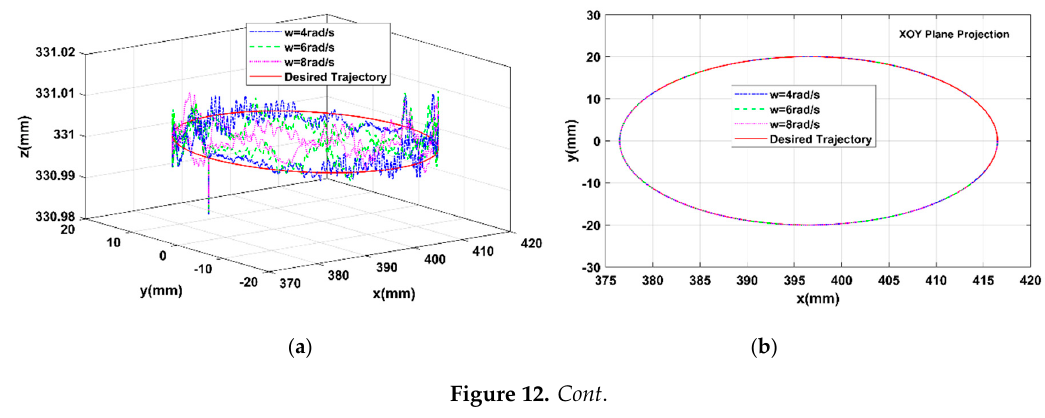
Figure 11. Robot end-point Cartesian following trajectory using PI controller (w = 2 rad/s). ( a ) 3D image; ( b ) XOY planar projection; ( c ) XOZ planar projection; ( d ) YOZ planar projection.